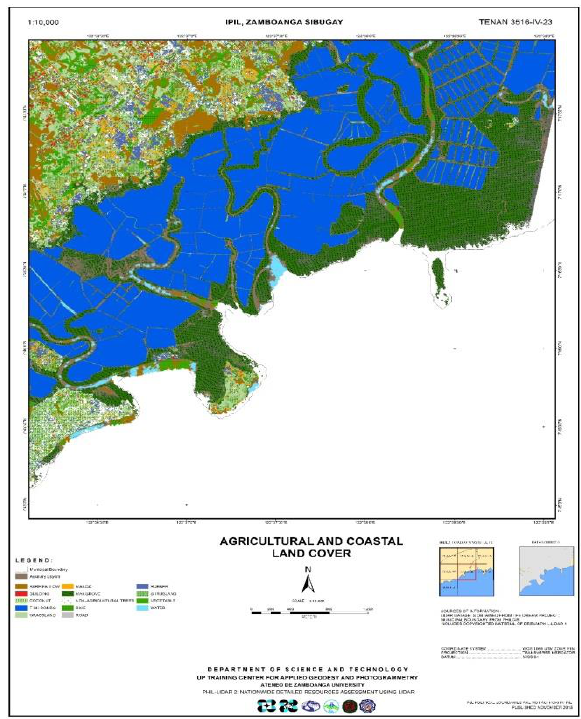
Figure 3. Sample agricultural and coastal land cover